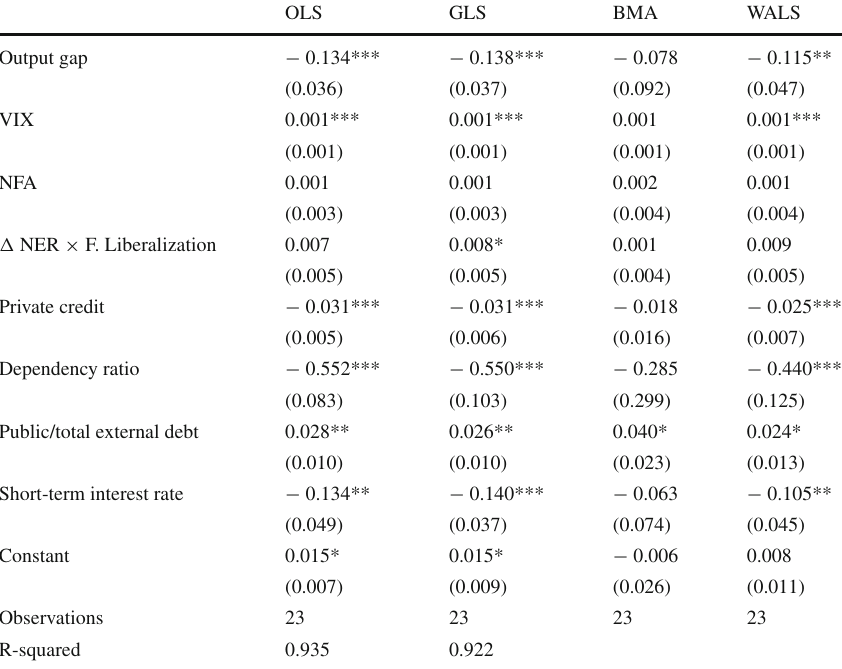
Table 3 Investment income balance regressions for